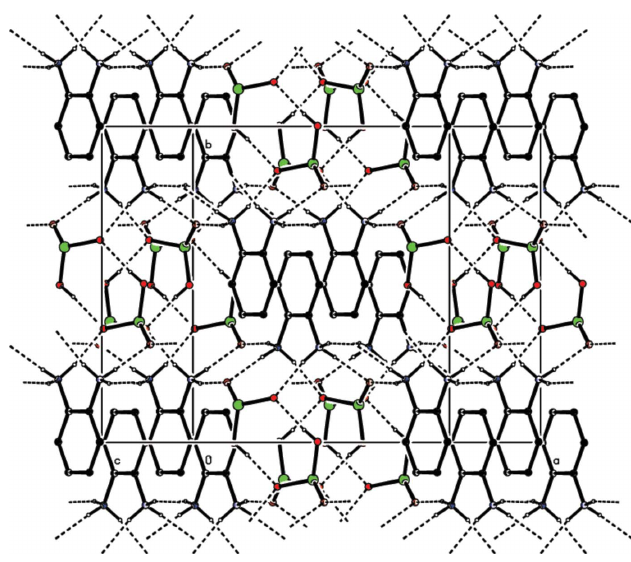
Figure 2 The crystal packing of the title molecular salt viewed along the c axis. The hydrogen bonds are shown as dashed lines. H atoms not involving in hydrogen bonding have been omitted for clarity.